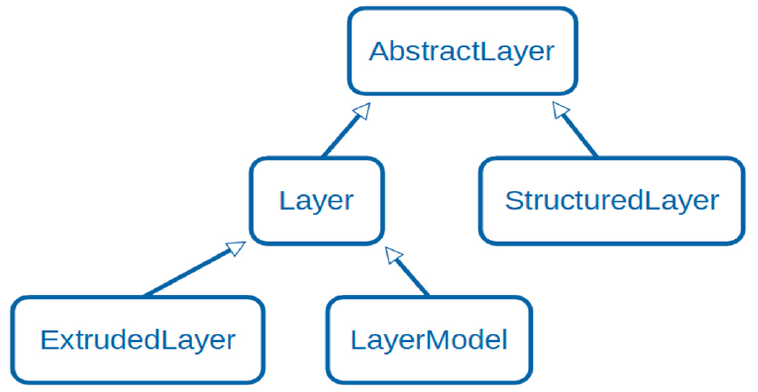
Figure 1. Simplified UML class diagram of the ALAMOS data model based on layers.